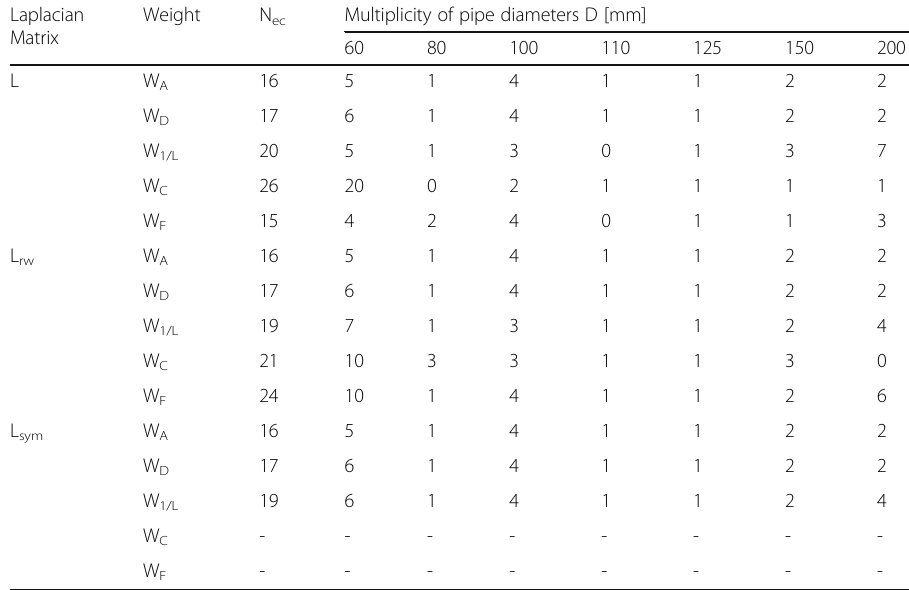
Table 4 Characteristics of the edge-cut set obtained with the three tested algorithms and the five assumed pipe weights